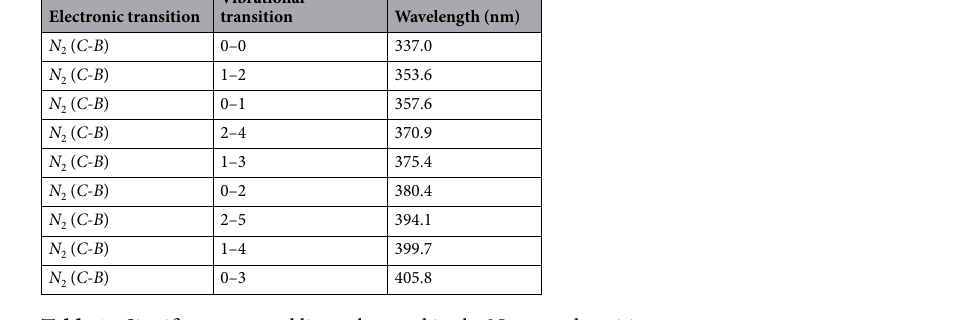
Table 1. Significant spectral lines observed in the N 2 second positive